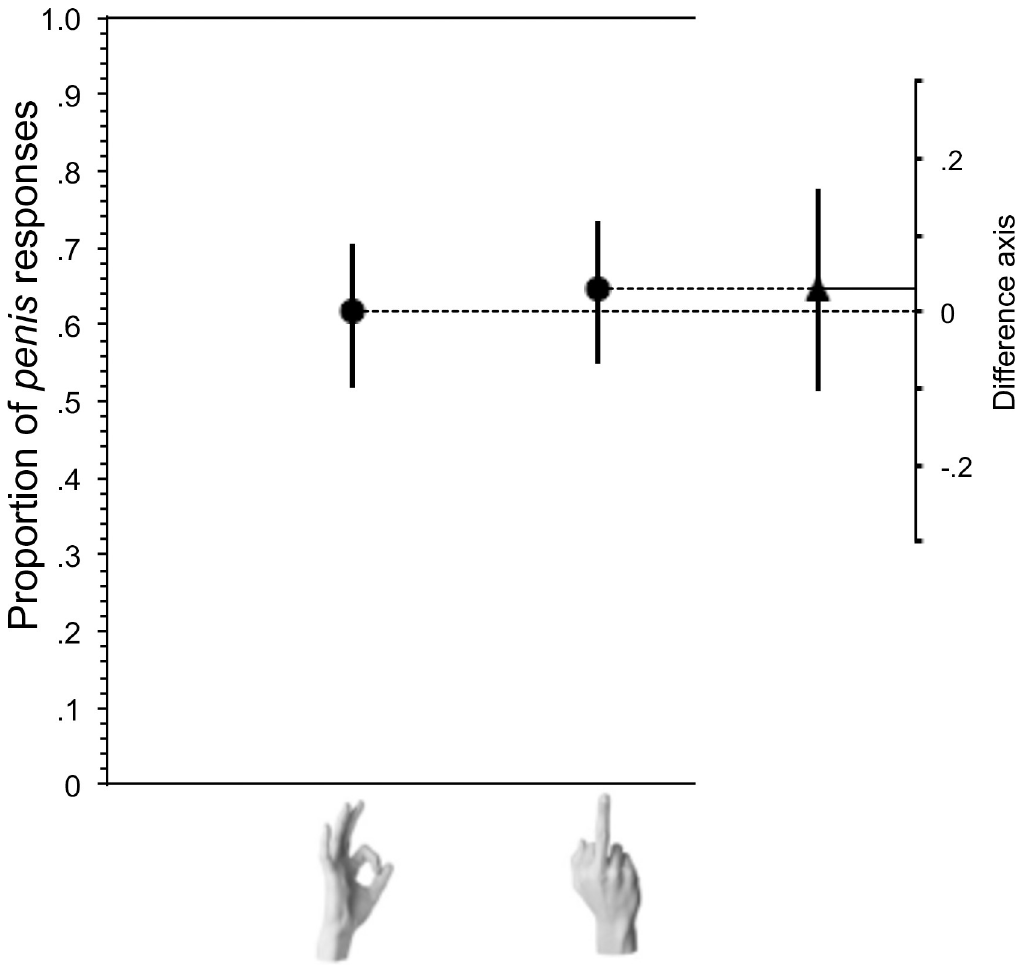
Fig 3. Effect of preceding gesture on completion of word completion prompt: p e n _ _. The proportion of penis completions of the p e n _ _ stem was not significantly higher following the Middle-Finger gesture than the A-OK gesture. Whiskers indicate 95% confidence intervals. The difference between the group values, with its 95% confidence interval, is shown on a floating difference axis at the right.